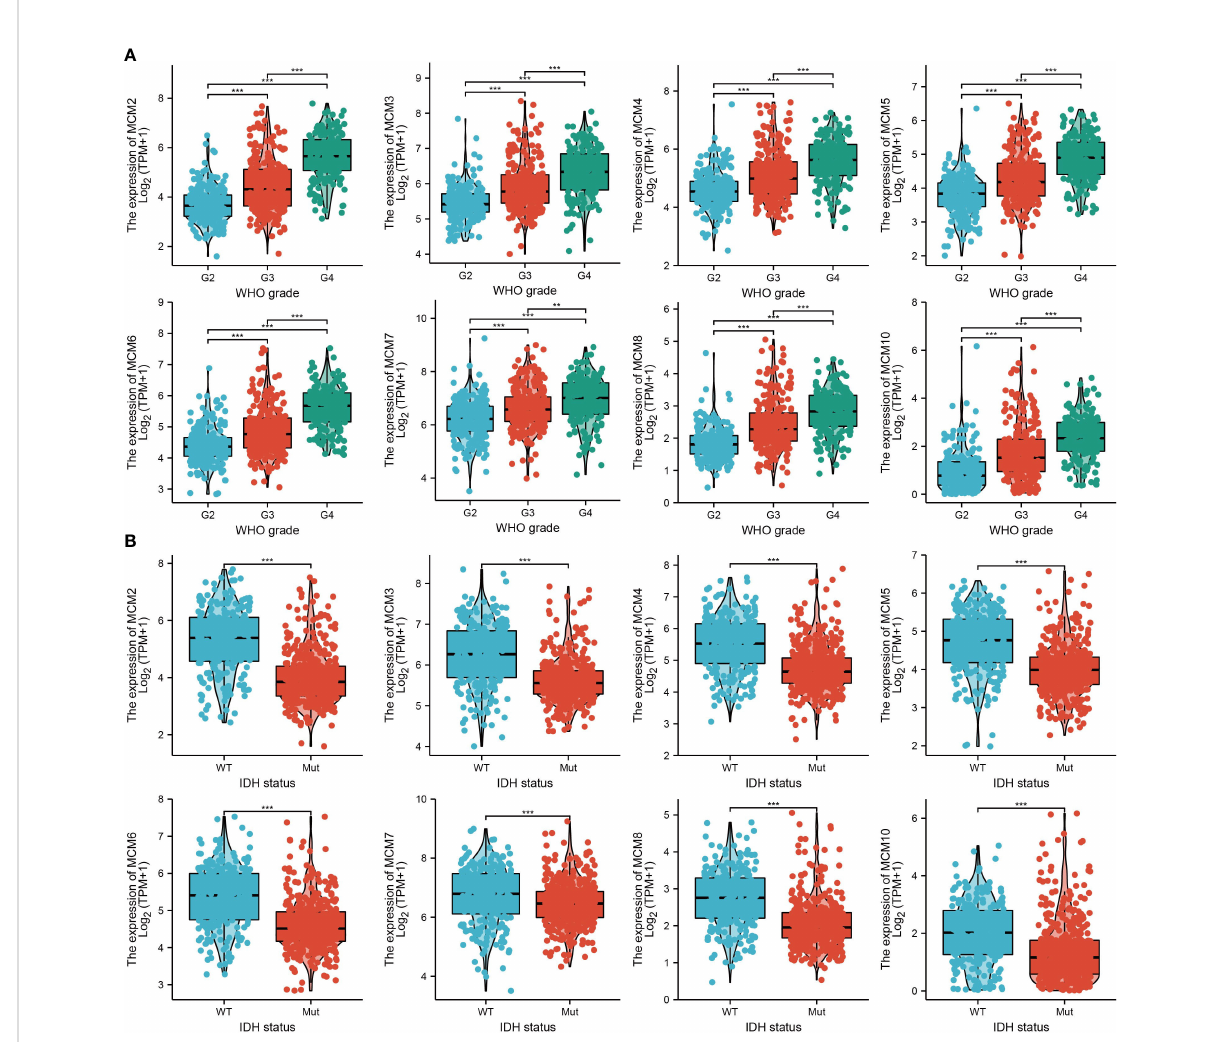
FIGURE 3 The correlation between MCMs expression and clinical information in glioma. (A, B) The correlation between MCMs expression and clinical features, including the higher tumor grades and IDH mutation status in glioma based on TCGA-glioma. **p < 0.01, ***p < 0.001. IDH, Isocitrate